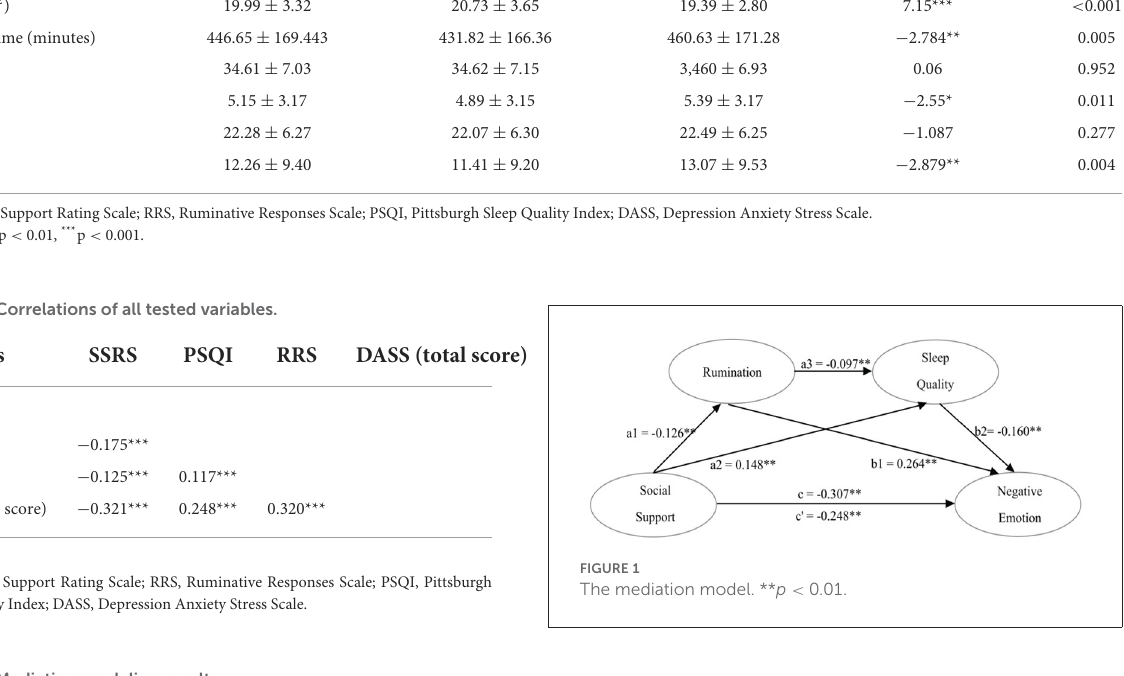
TABLE 3 Mediation modeling results.